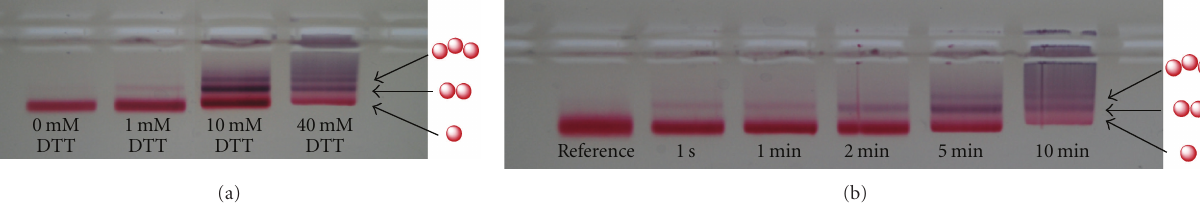
Figure 2: Agarose gels after electrophoretic purification of reaction mixes. (a) 1 s incubation time with a 50mM NaCl and varying DTT concentrations: 0 mM (lane 1), 1mM (lane 2), 10mM (lane 3), and 40 mM (lane 4). (b) 50 mM NaCl and 1 mM DTT with di ff erent